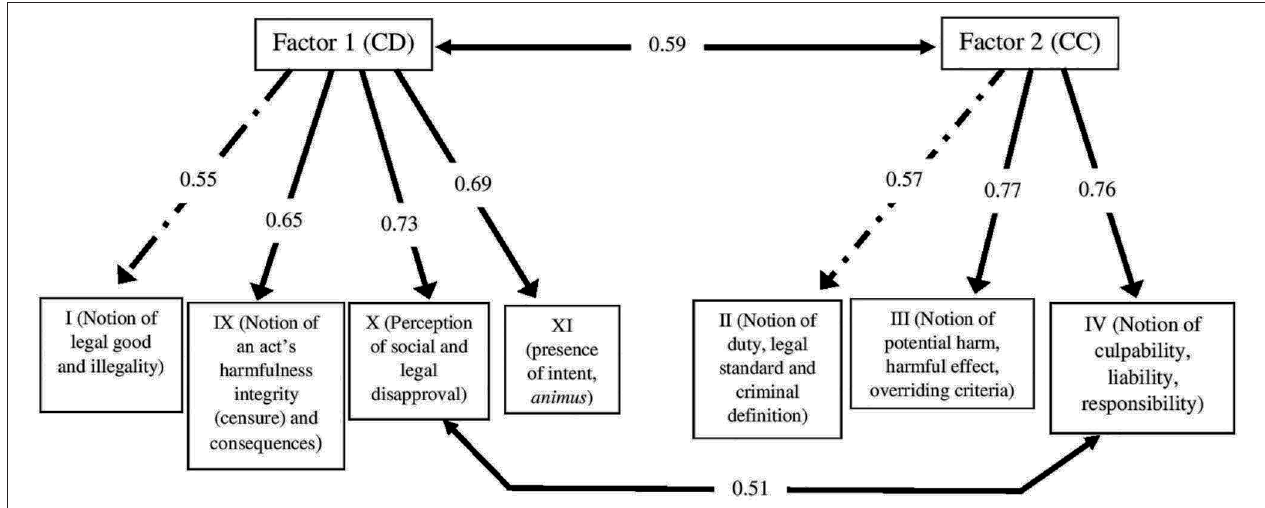
FIGURE 2 | Model for exploratory analysis of the CRS (without subdivision of items). CD, capacity for self-determination; CU, capacity for